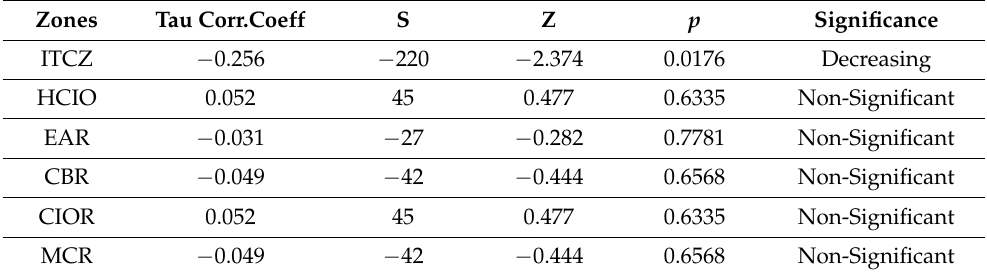
Table 1. Mann Kendall Trend Test of OLR in W/m 2 for JJAS.